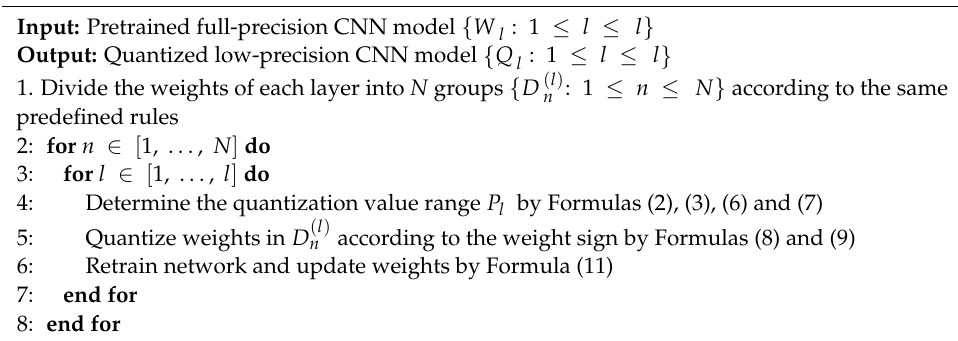
Algorithm 1: Global Sign-Based Network